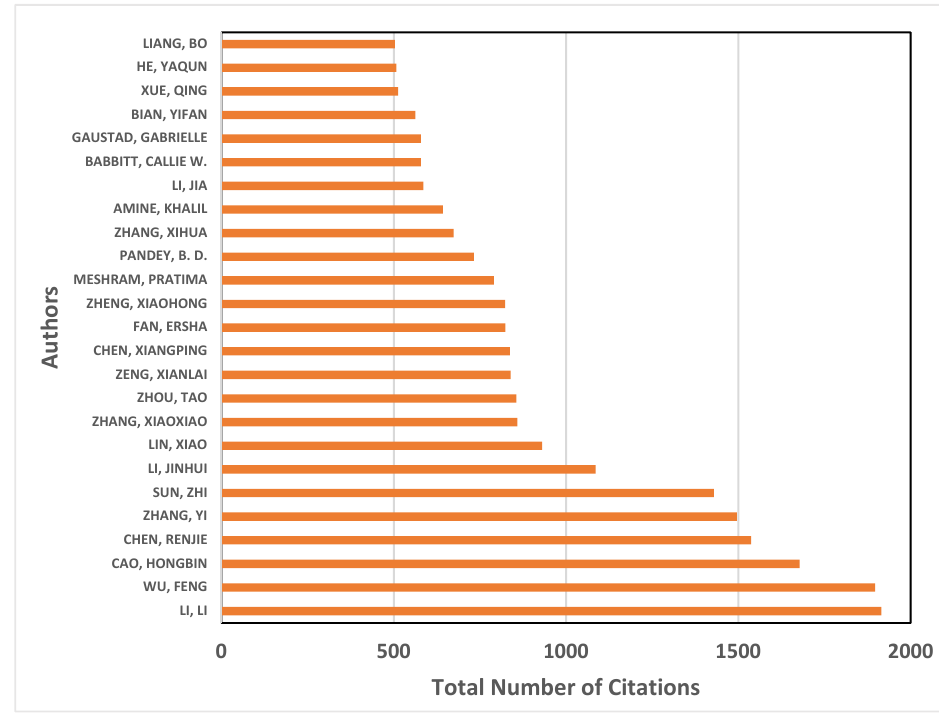
Figure 16. Authors with more than 500 total citations.